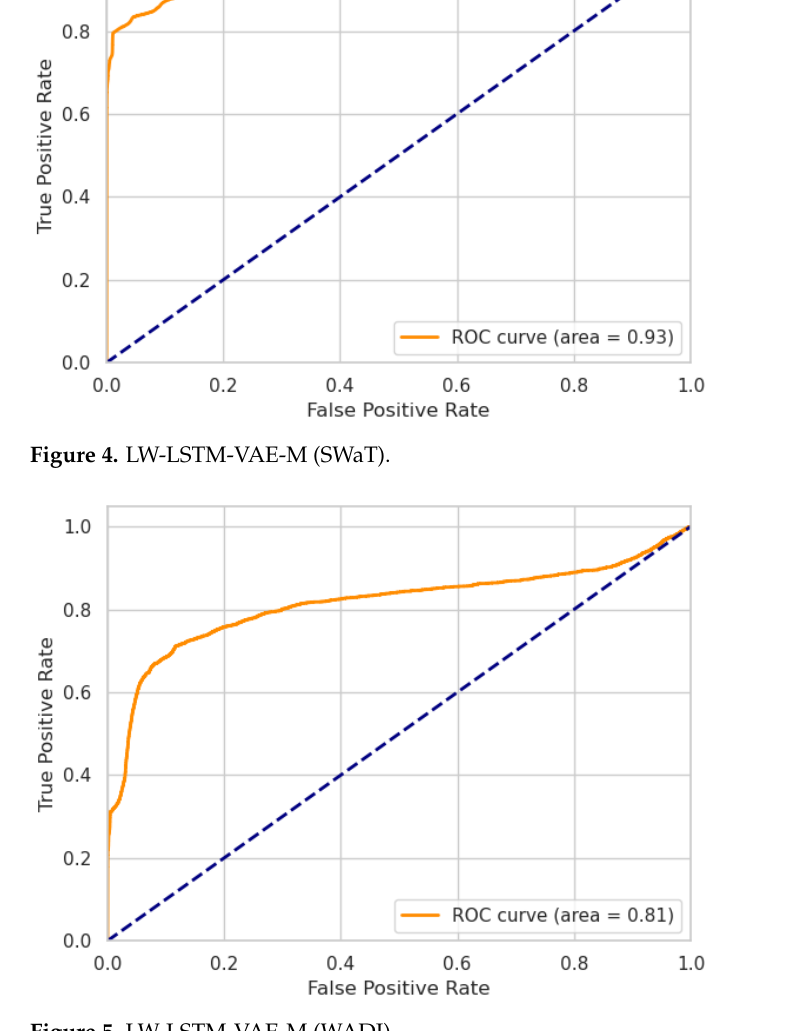
Figure 5. LW-LSTM-VAE-M